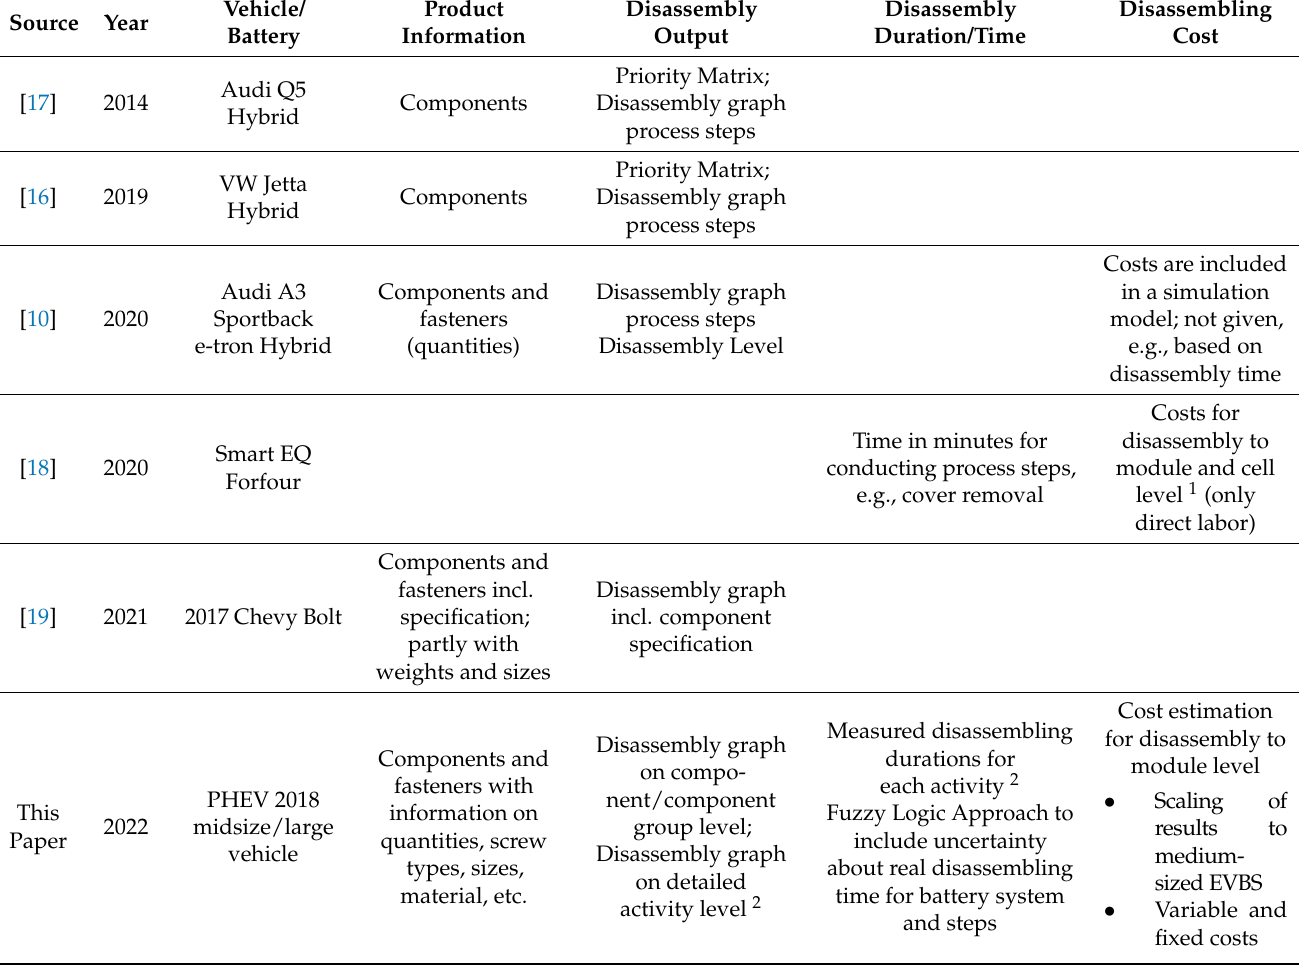
Table 1. Literature with reported EV battery disassembly experiments and selected reported output